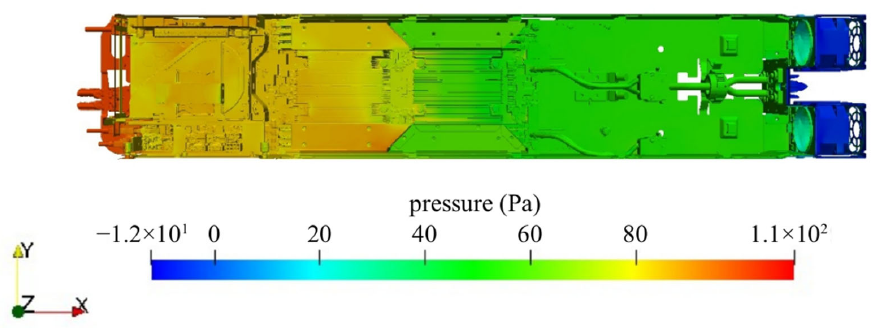
Figure 11. Pressure distribution over the mid plane of the server.